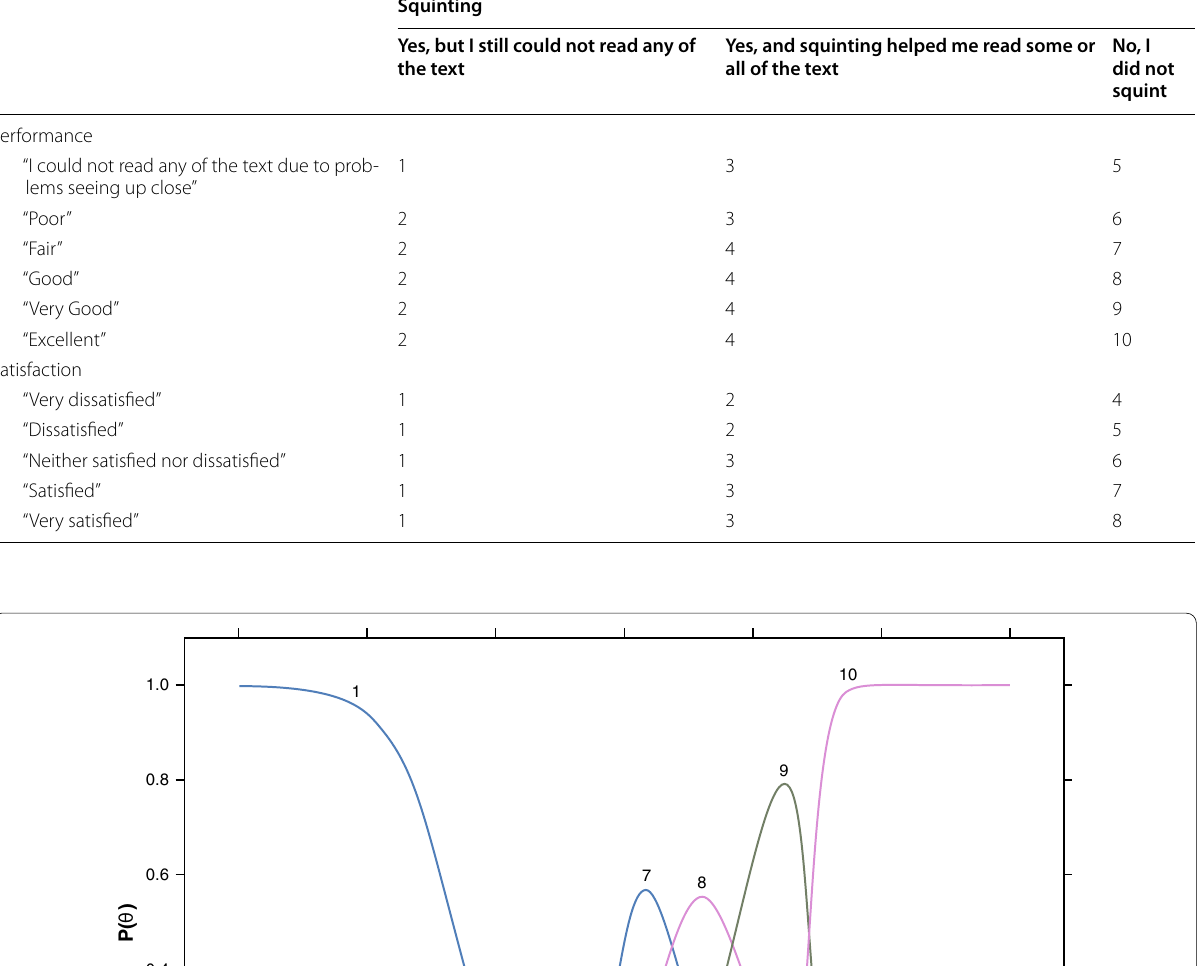
Squinting and Satisfaction +